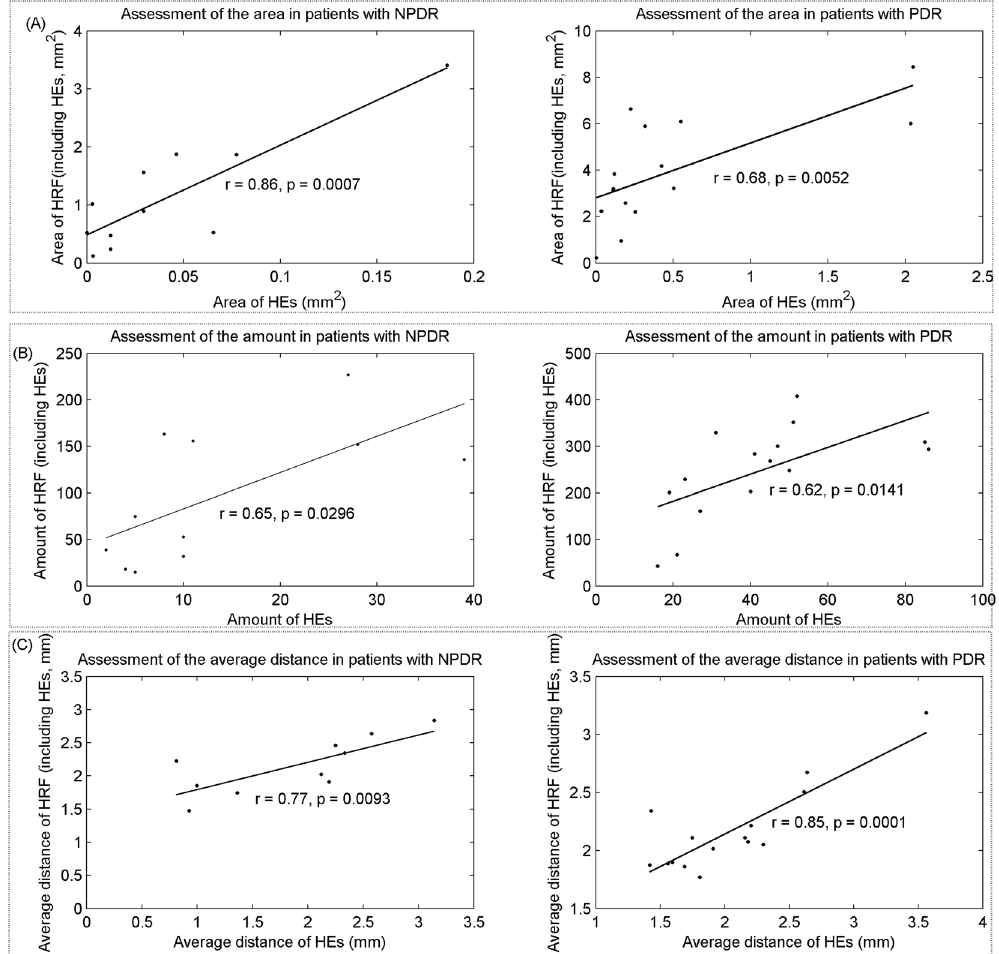
Figure 8. ( A ) Area assessment of hard exudate and hyper-reflective foci (including hard exudates) in patients with NPDR and PDR on SD OCT, ( B ) Results from the amount assessment of hard exudate and hyper-reflective foci (including hard exudates) in patients with NPDR and PDR on SD OCT. ( C ) Average distance to macular fovea for hard exudate and hyper-reflective (including hard exudates) in patients with NPDR and